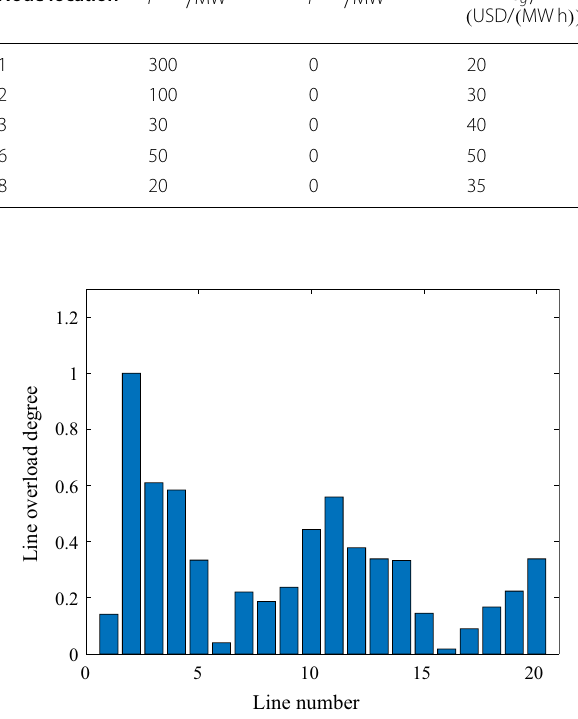
Fig. 5 Line power flow accounts for the proportion of capacity during normal operation